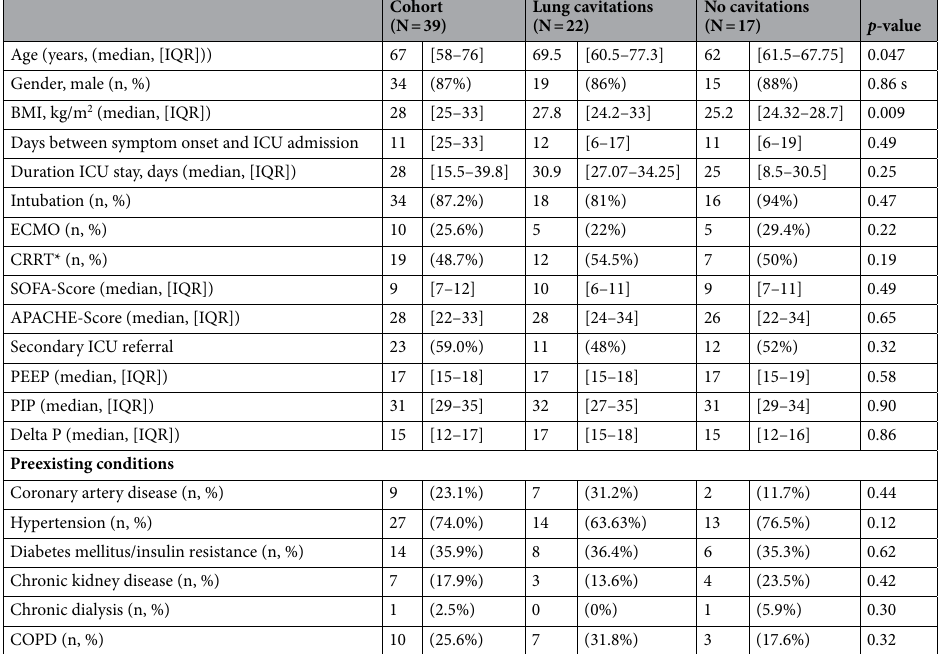
Table 1. Patient characteristics of total cohort and the groups with and without cavitary lesions on CT scan. ECMO, Extracorporeal Membrane Oxygenation; SOFA, Sequential Organ Failure Assessment; CRRT, Continuous Renal Replacement Therapy; APACHE, Acute Physiology And Chronic Health Evaluation. PEEP, positive endexspirarory pressure, PIP, Peak inspiratory pressure, deltaP, driving pressure. *Until the time point, when the study was censored.